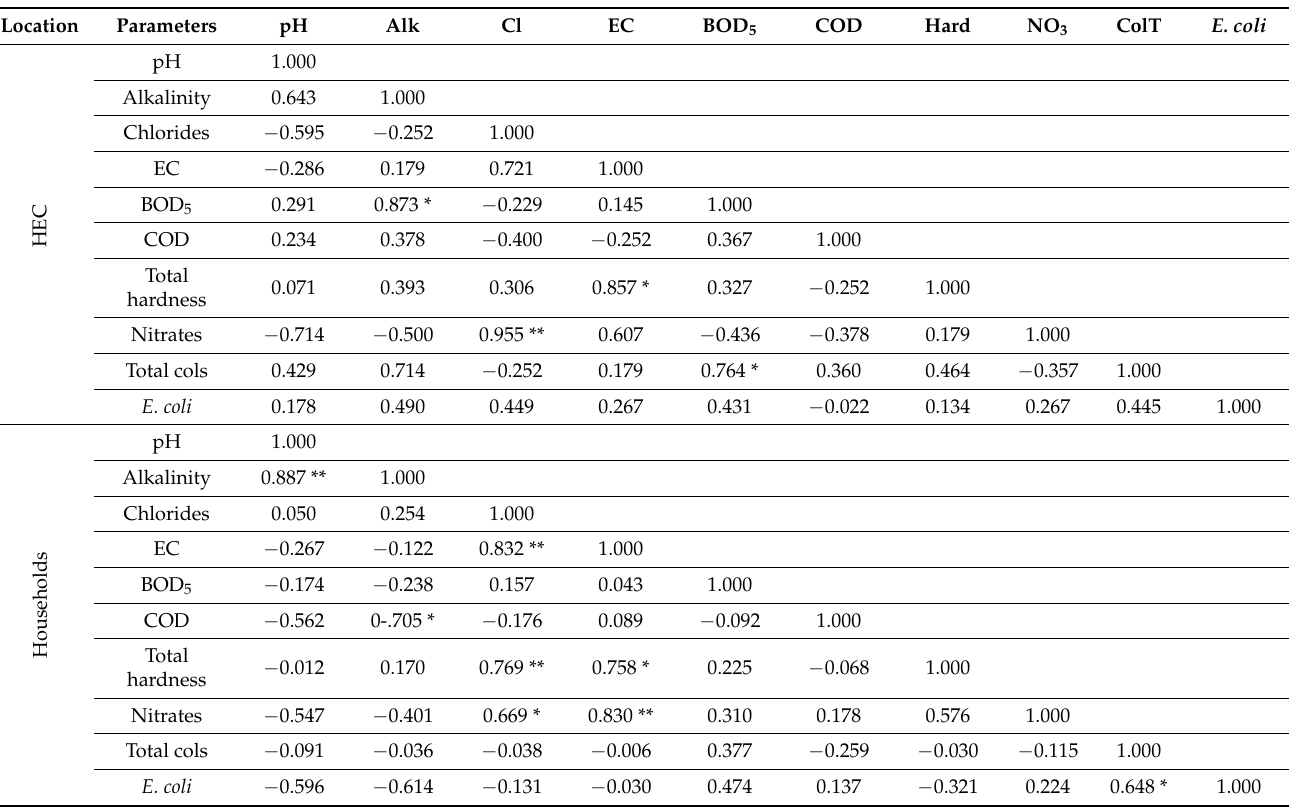
Table 4. Spearman’s coefficient between the physico-chemical and microbiological parameters of the higher education center (HEC) and